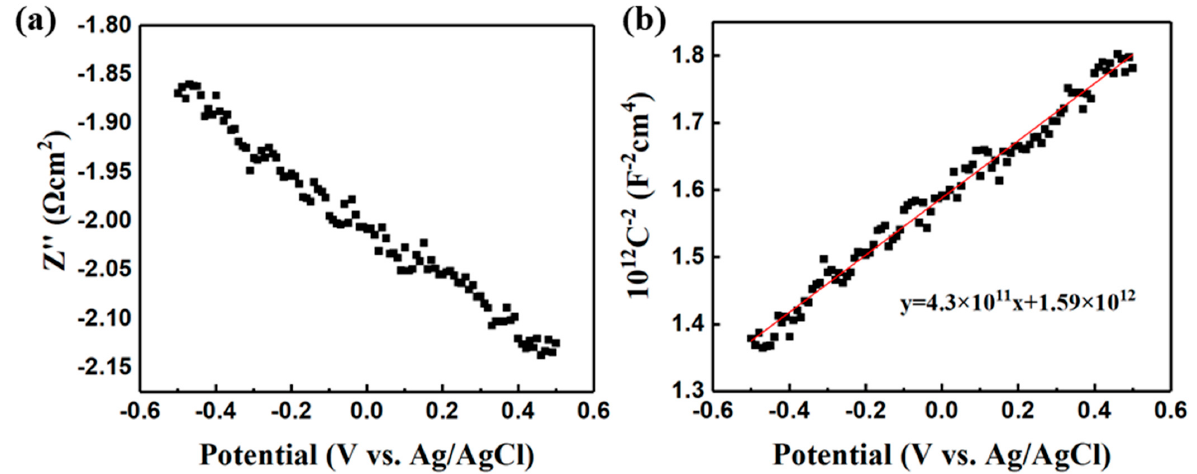
Figure 10. ( a ) Impedance potential plot of iron pyrite film in neutral solution (Na 2 SO 4 , 0.1 M), and ( b ) the Mott–Schottky plot of the iron pyrite film.